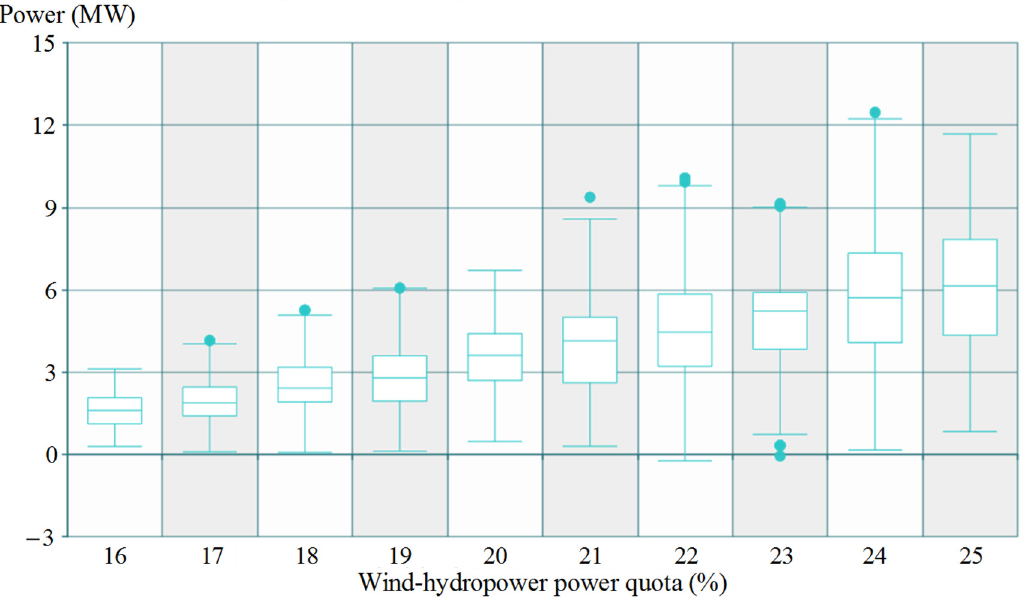
Figure 12. Box plot of the wind power fluctuation under different wind-hydropower quota scenarios. The “W” is short for the unit of wind power, and “%” is short for the unit of energy quota.